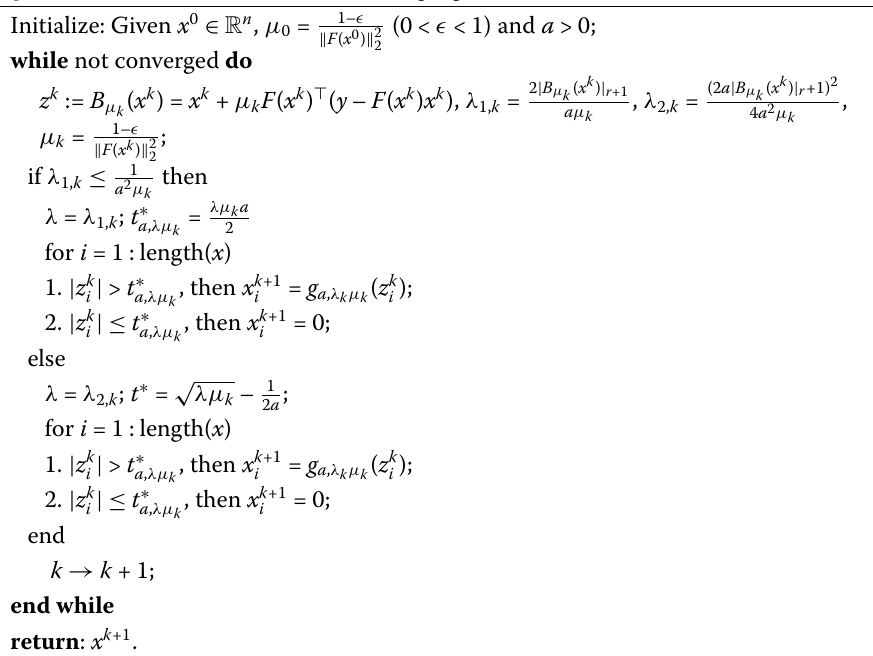
Algorithm 1 Iterative fraction thresholding algorithm